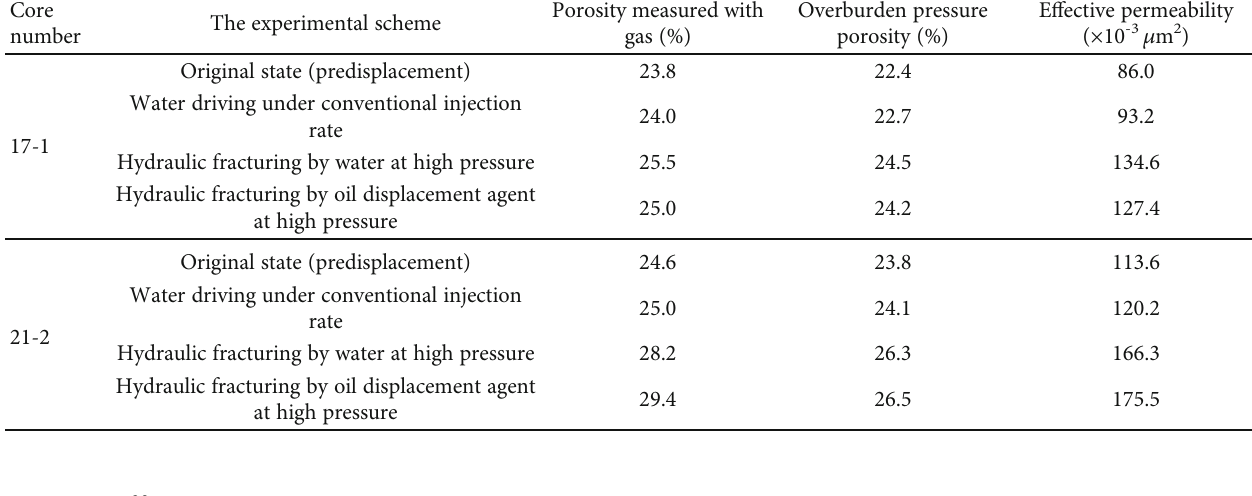
Table 2: Results of porosity and permeability measurements in natural cores.